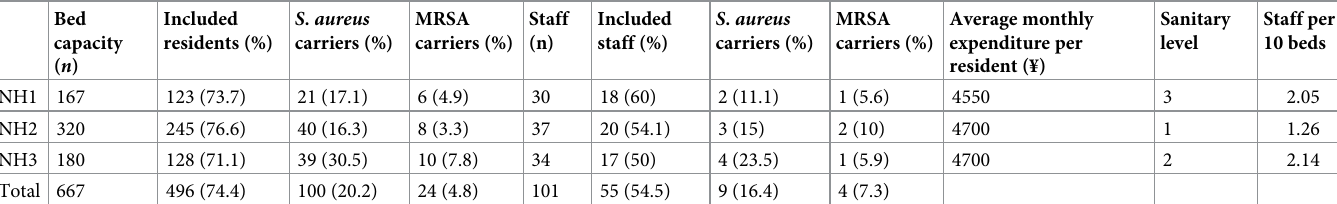
Table 1. General information of three nursing homes, including residents and staff, Staphylococcus aureus and MRSA carriers. Bed